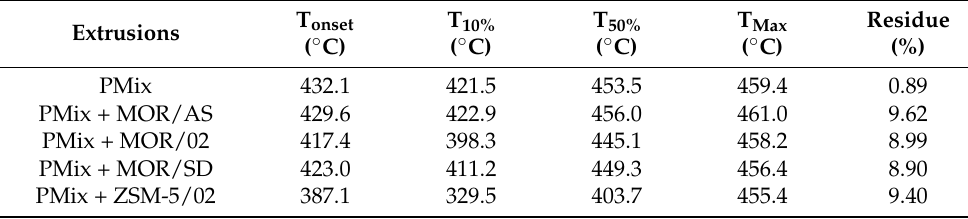
Table 5. TGA results for the PMix sample with all catalysts.